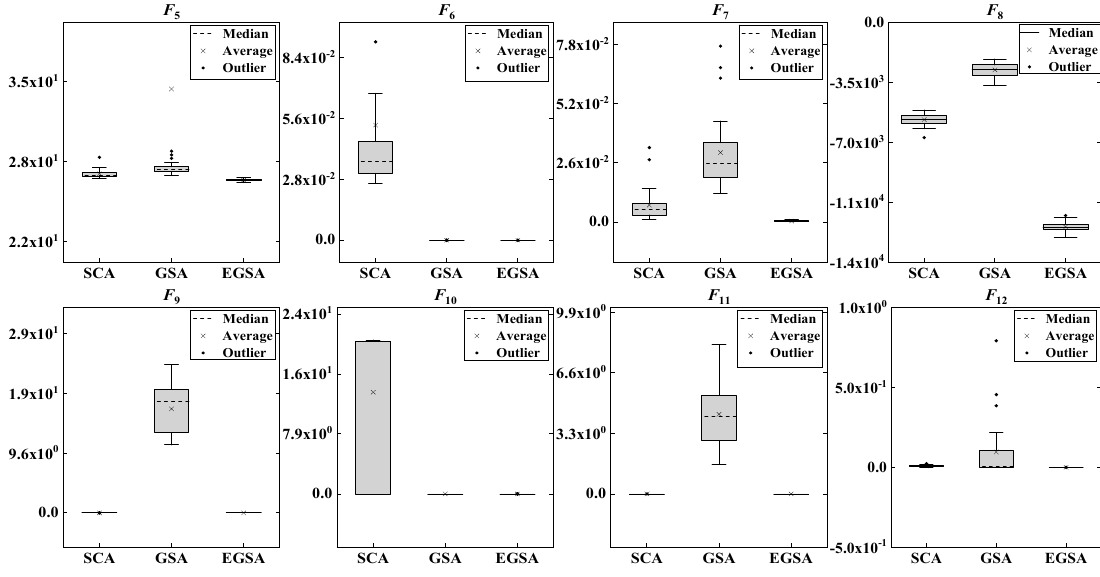
Figure 2. Box and whisker test of three algorithms for 12 functions with 30 variables.